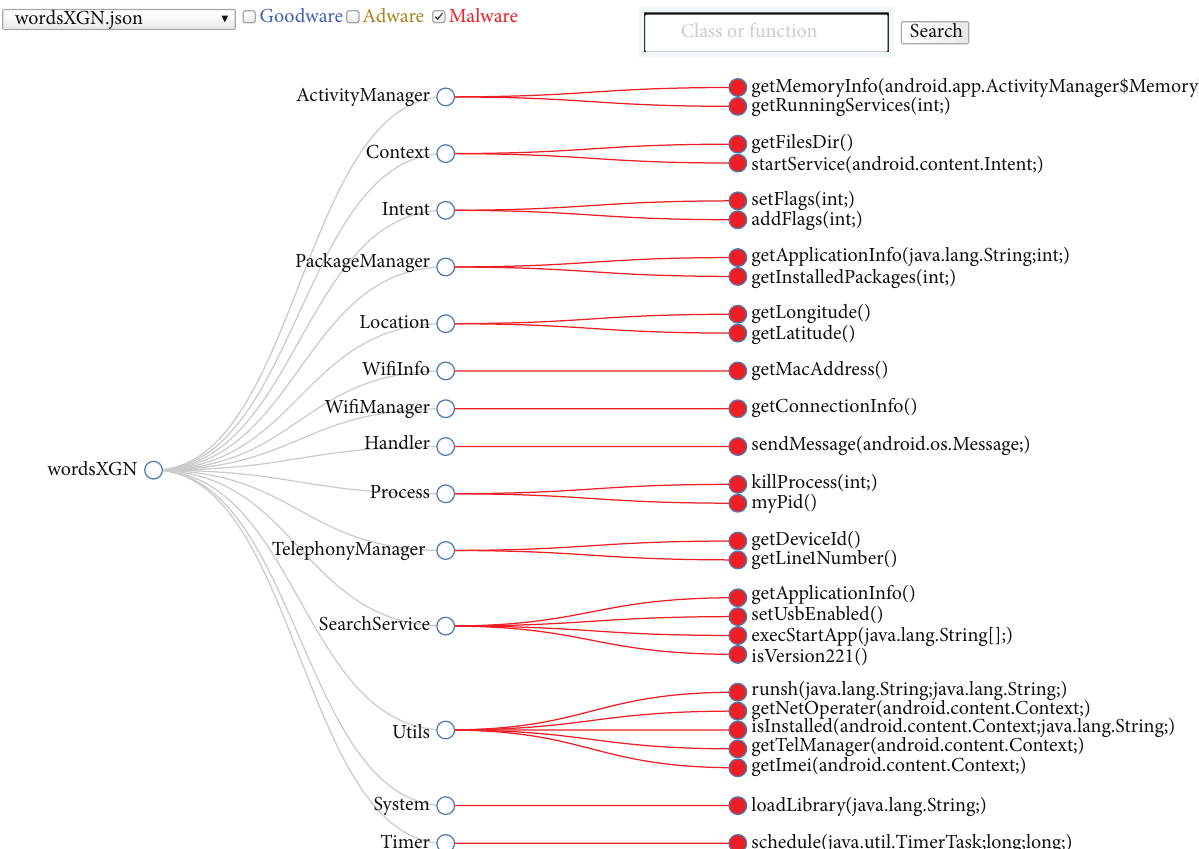
Figure 7: Visualization of the malicious API calls detected by our system for DroidKungFu1 . Note the chosen options of the monitored malware in the dendrogram at the upper left side. First, we shorten version of the package name ( wordsXGN ) of the malware in the combobox. Next we have three checkboxes, namely, Goodware, Adware, and Malware. In this graph, only the red checkbox has been activated in order to conduct the visual analysis. The full package name of DroidKungFu1 is com . nineiworks . wordsXGN